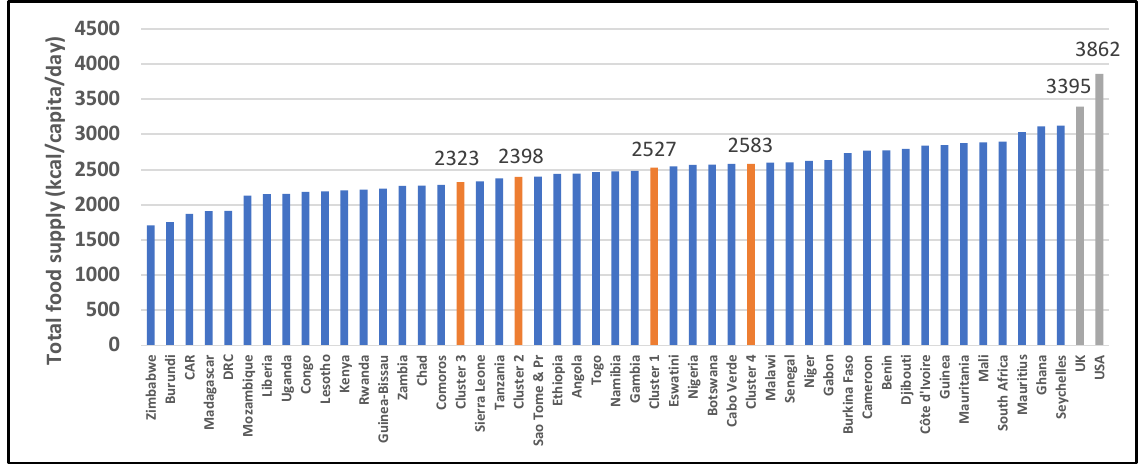
Figure 5. Data from food balance sheets for 2019 indicating per capita (kcal) of total food supply energy intake per day. Red columns indicate medians of clusters; source: [25]. Table 5. Median and interquartile range values of anthropometric and health data of Clusters